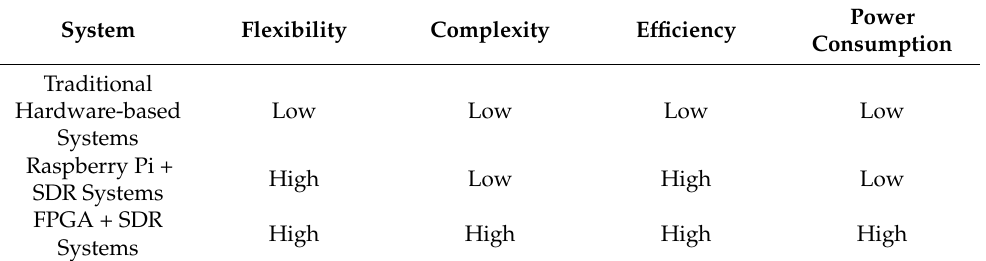
Table 2. Comparison between different design approaches for communication subsystems in small